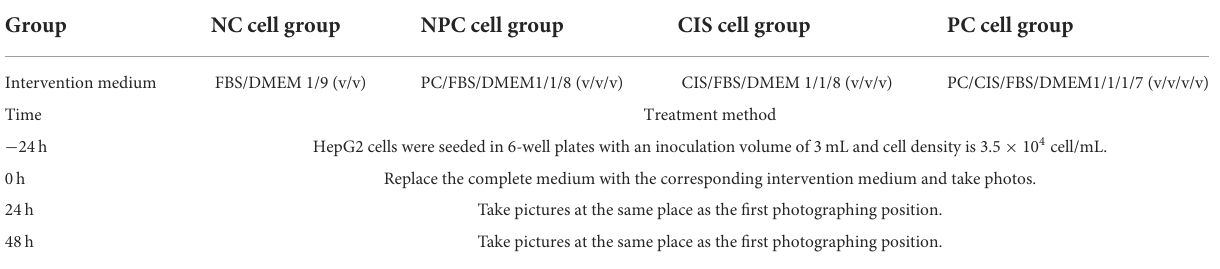
TABLE 2 The in vitro experimental design protocol. Group NC cell